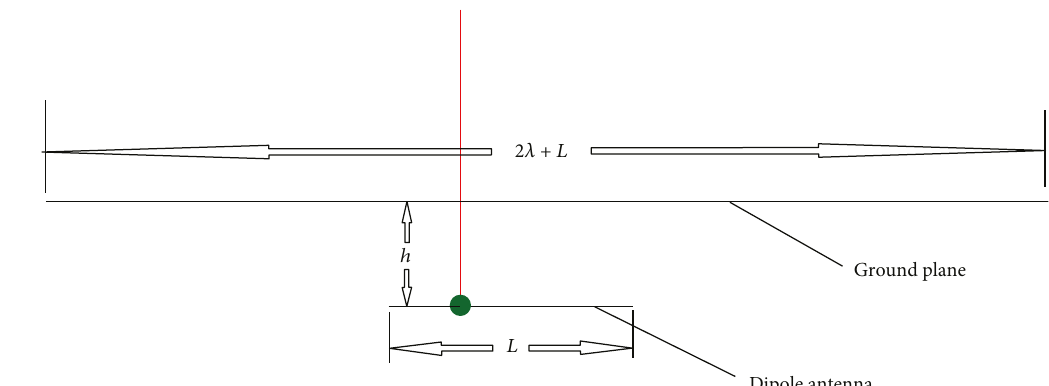
Figure 14: Ground plane o ff set de fi ned for the wing o ff set study.